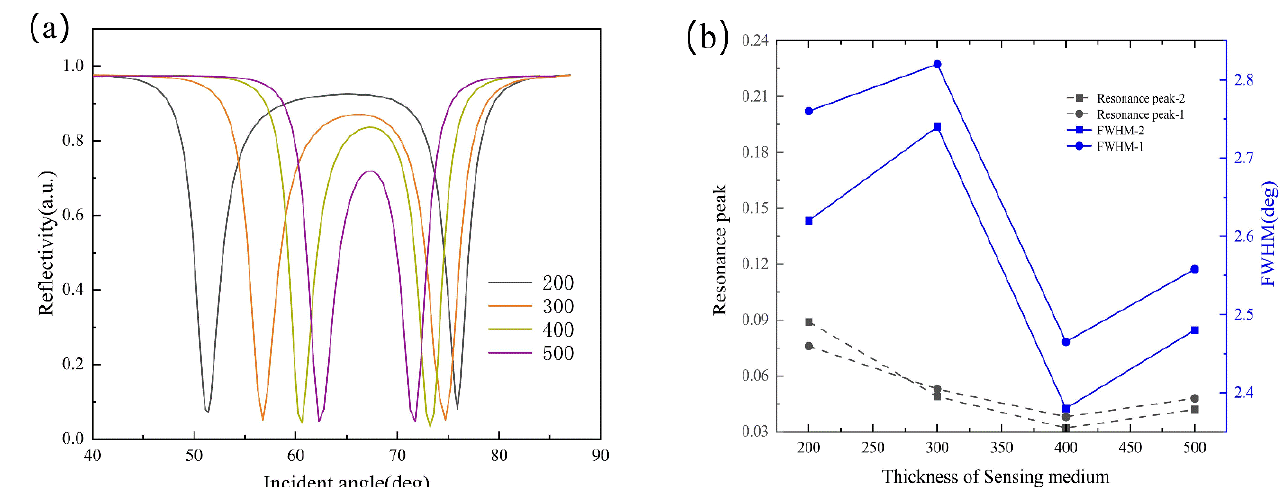
Figure 8. ( a ) Reflectivity variation curve under angle modulation at different detection media thick- nesses; ( b ) half ‐ width height and minimum reflection relationships at different media thicknesses.